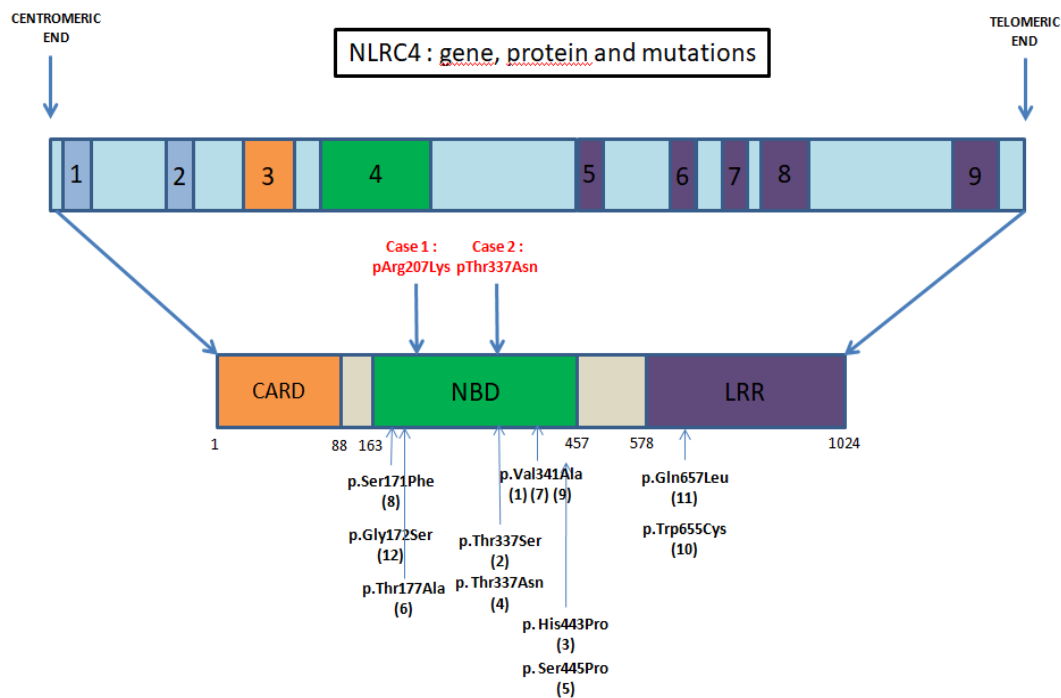
Figure 3. NLRC4 gene, protein and GOF mutations clinically described in the literature. [1] Romberg et al. 2014, [2] Canna et al. 2014, [3] Kitamura et al. 2014, [4] Volker-Touw et al. 2017, [5] Kawasaki et al. 2017, [6] Canna et al. 2017, [7] Liang et al. 2017, [8] Barsalou et al. 2018 (variant mutation pVal341Leu), [9] Mohggadas et al. 2018, [10] Chear et al. 2019, [11] Wang et al. 2020.